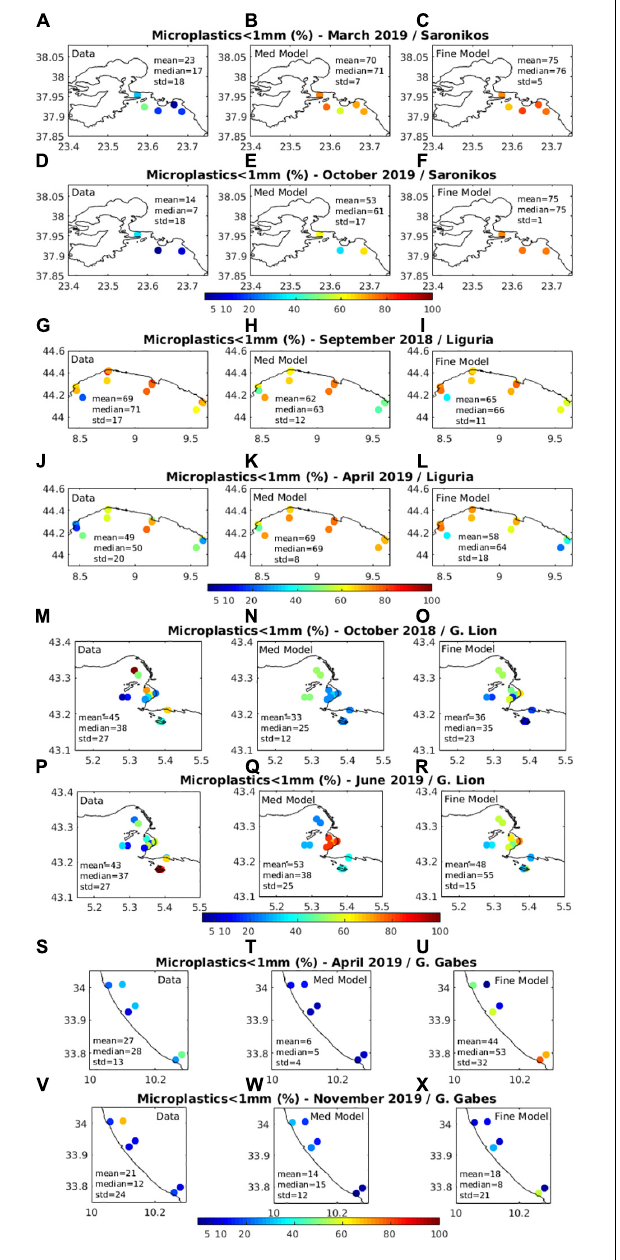
FIGURE 8 | Microplastics small size ( < 1mm) contribution (%), simulated with the Mediterranean (Med model) and fine-resolution (Fine model) models, against in situ data collected in the four key study areas, during the two campaigns. (A–F) Saronikos Gulf, (G–L) Ligurian Sea, (M–R) Gulf of Lion,